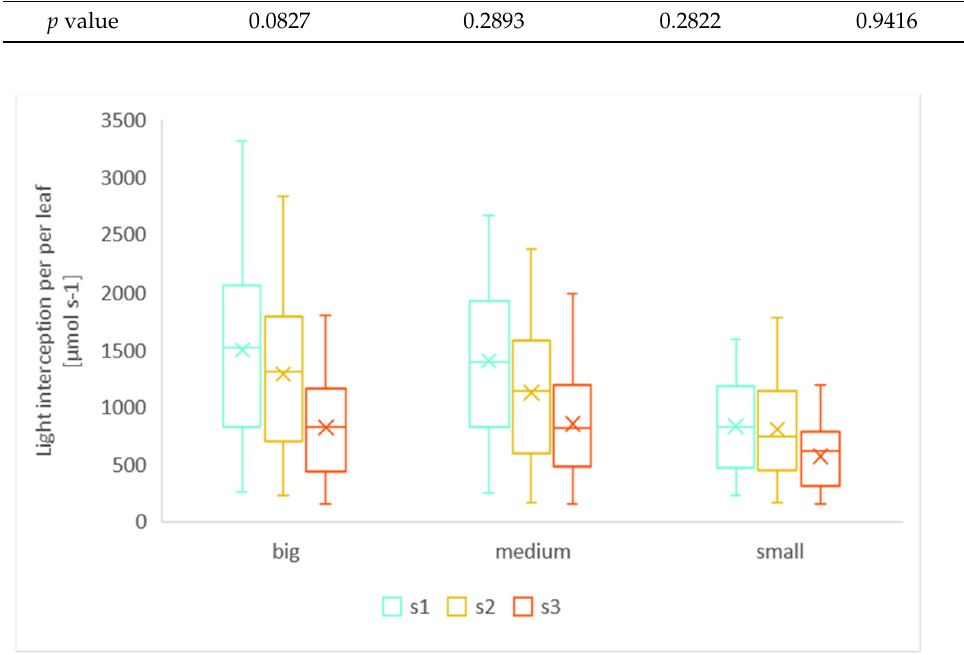
Figure A1. The simulated light interception per leaf for three plant groups (small leaf, medium leaf, and big leaf) and three scenarios (s1, s2, and s3).